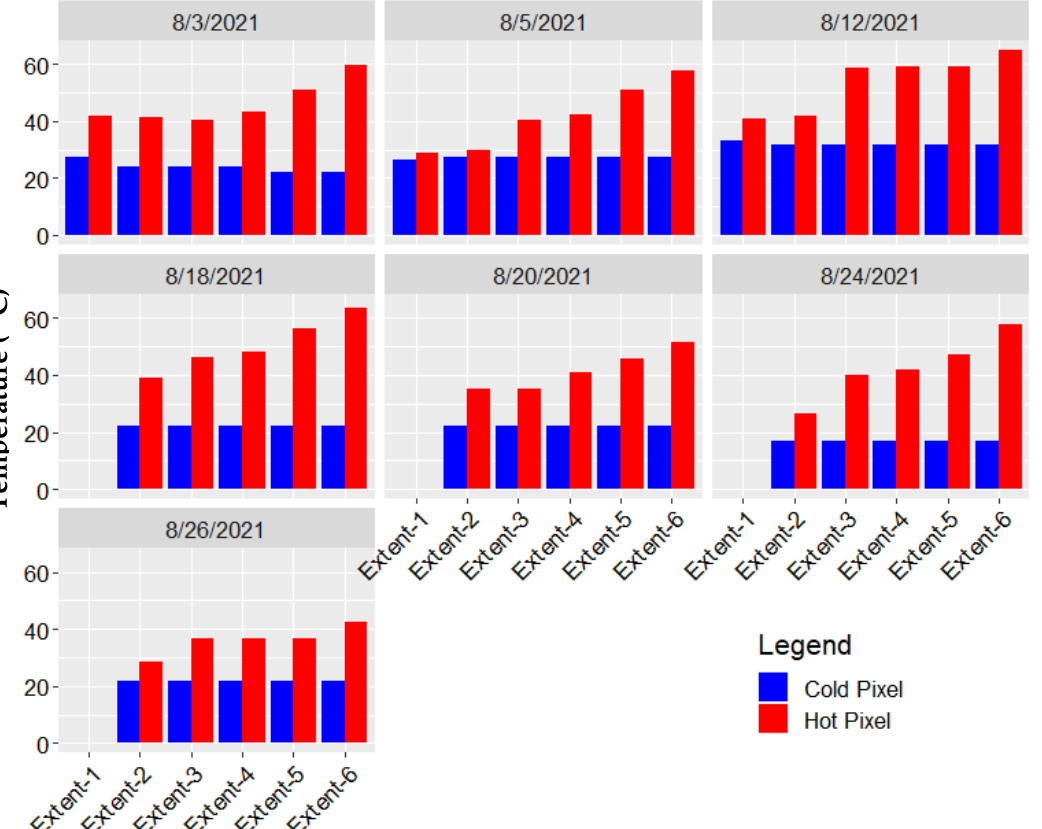
Figure 5. Hot and cold anchor pixels from each image extent for the 7 data collection campaign days.